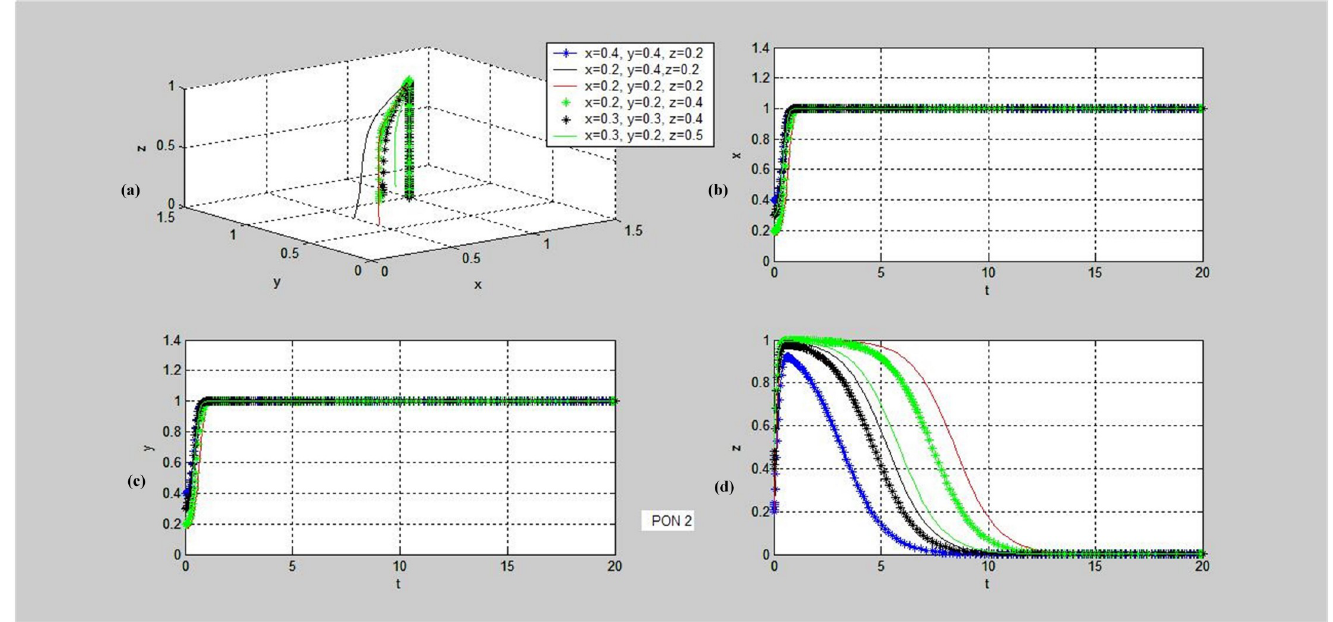
Fig 6. Evolutionary dynamics of strategies stable in (cooperation, cooperation, non-supervision). PON-Proposition. (a)~(d) demonstrate the phase trajectories of x, y, z and (x, y, z) in the game situations shown in Proposition 2: (a) The phase trajectory of (x, y, z) of the entire evolutionary game system over time t; (b) the dynamic evolution characteristic of x, i.e., the proportion of individuals choosing Cooperation strategy in population PPP over time t; (c) the dynamic evolution characteristic of y, i.e., the proportion of individuals choosing Cooperation strategy in population DC over time t; (d) the dynamic evolution characteristic of z, i.e., the proportion of individuals choosing Non-supervision strategy in population TPIP over time